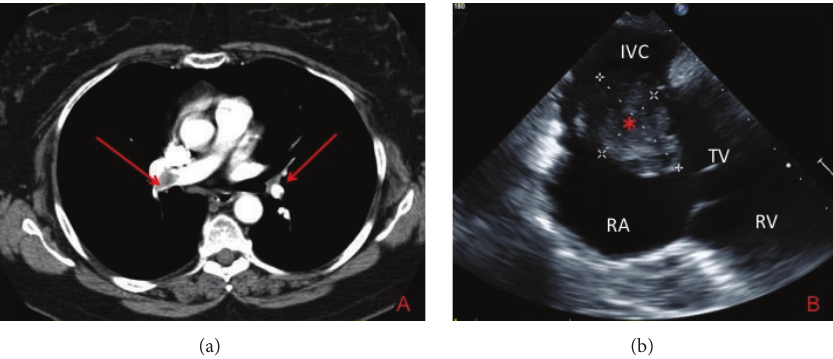
Figure 2: (a) Right and left pulmonary artery filling defects on CTPA and (b) TOE demonstrating the head of the mass protruding from the IVC into the RA. The TV was not damaged although the mass protruded through the TV into the RV during diastole. IVC: inferior vena cava; RA: right atrium; TV: tricuspid valve; RV: right ventricle.